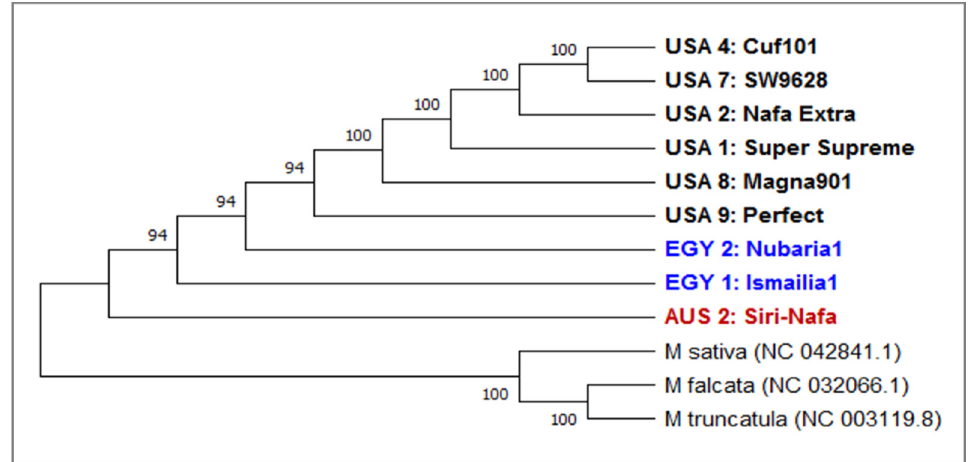
Figure 6. A consensus phylogenetic tree constructed based on trnH DNA barcoding regions for nine M. sativa cultivars using the MEGAX software. The evolutionary history was inferred using the UPGMA method. The optimal tree has a branch length of 0.905444. The bootstrap values are shown next to the branches. The evolutionary distances were computed using the Jukes-Cantor method and are in the units of the number of base substitutions per site. This analysis involved 12 nucleotide sequences. All ambiguous positions were removed for each sequence pair (pairwise deletion option). There was a total of 60 positions in the final dataset. The tree clearly isolated the three outgroups from the major clade of the eight alfalfa cultivars used for trn H barcoding. In this clade, AUS2-Siri Nafa and the two Egyptian cultivars sequences